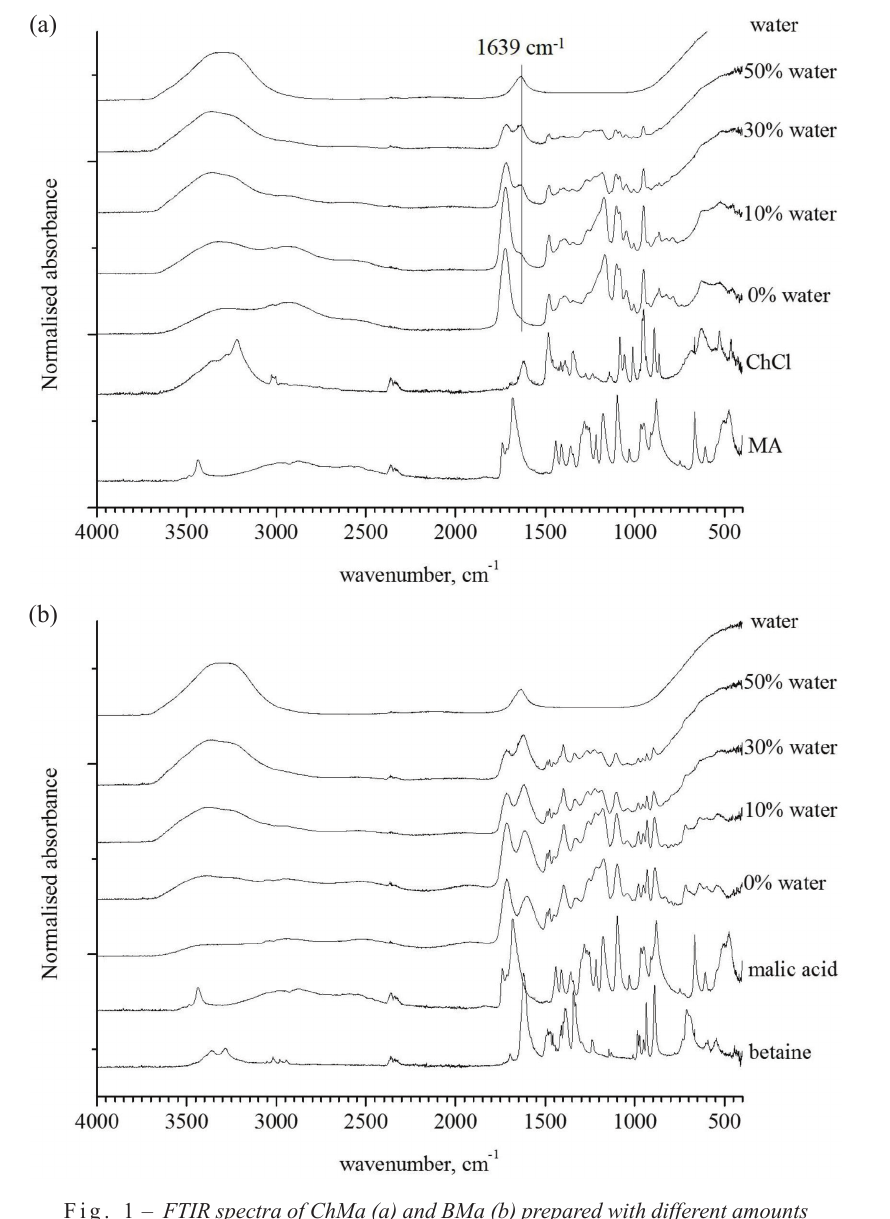
Fig. 1 – FTIR spectra of ChMa (a) and BMa (b) prepared with different amounts of water (0 to 50 % by